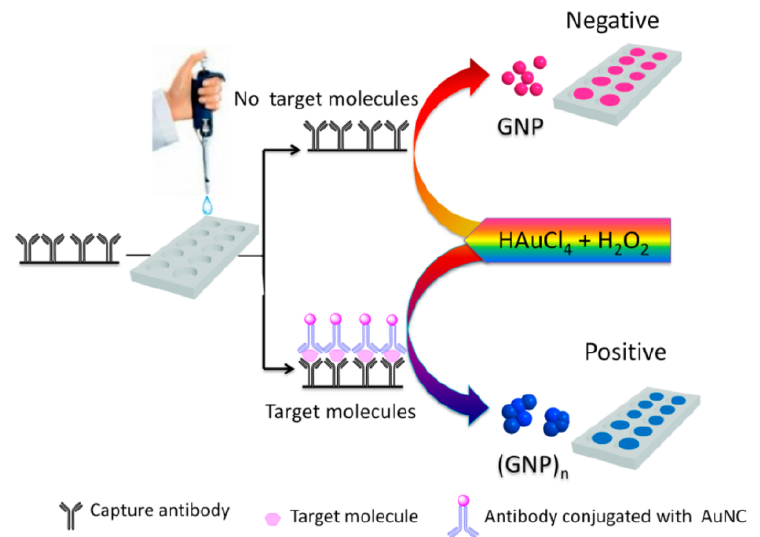
Figure 12. Sandwich ‐ based plasmonic Ab ‐ Au nanozymatic sensor for the determination of different molecules of biological interest. Reprinted with permission from [140]. Copyright © 2016 American Chemical Society.